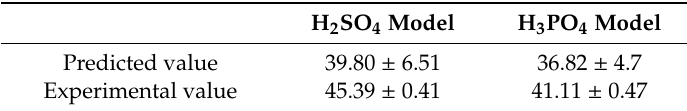
Table 8. Comparison between predicted and experimental value obtained with the optimum conditions of 85 ◦ C, 60 min and 60 mL / g ratio with H 2 SO 4 2 N and 90 ◦ C, 60 min and 60 mL / g ratio with H 3 PO 4 21 N in PDO tiger nut byproduct (g / 100 g of tiger nut byproduct dry weight).